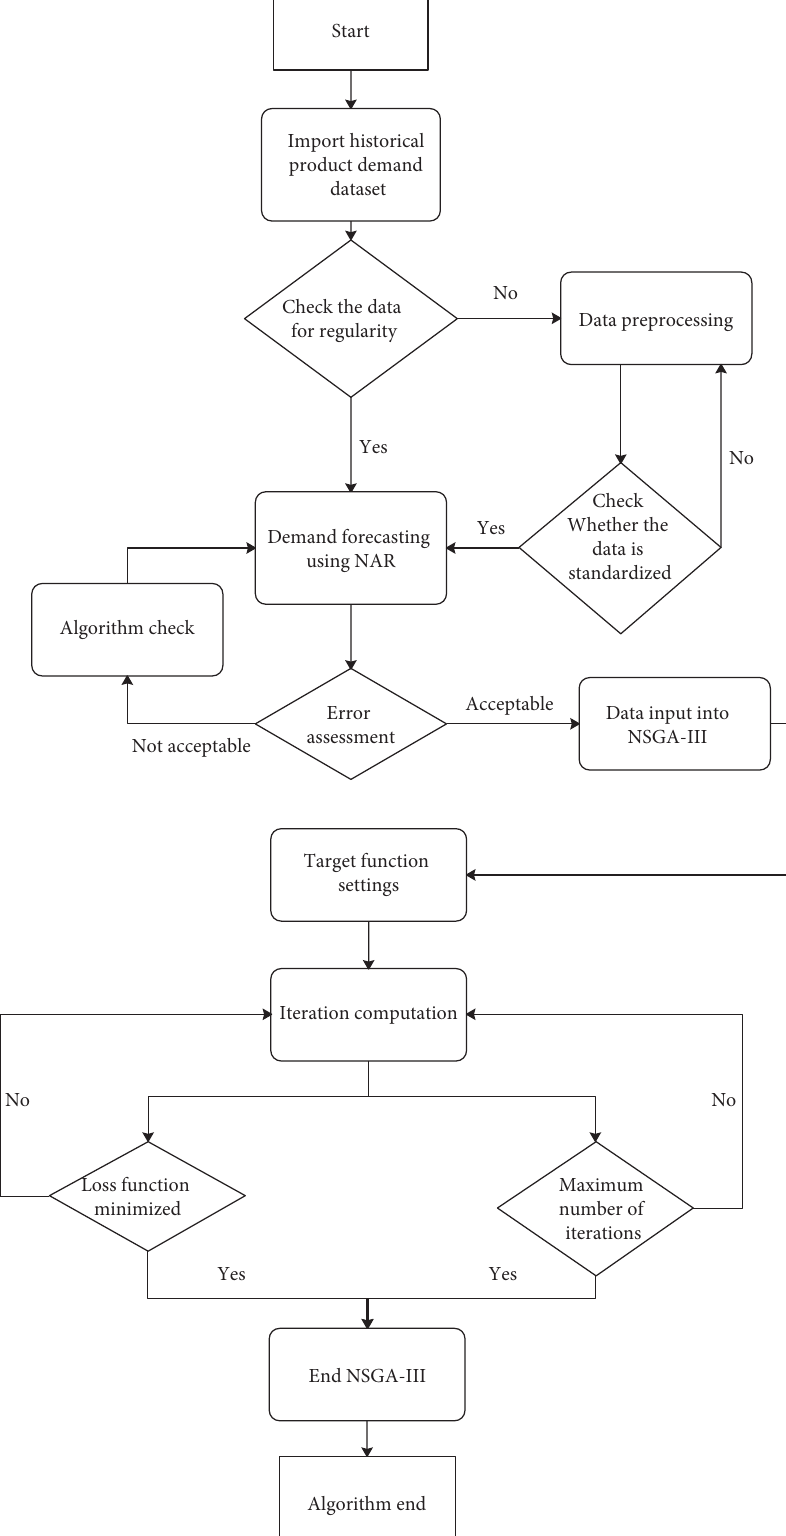
Figure 4: Steps of the storage space allocation algorithm based on nonlinear autoregressive neural network and nondominated sorting genetic algorithm